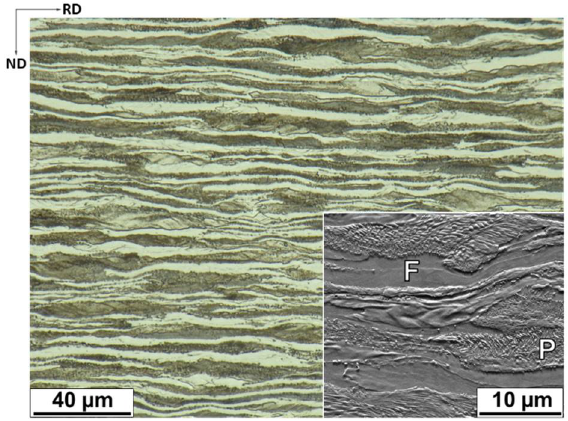
Figure 1. Microstructure of the steel in as-received 70% cold-rolled steel. Cold-rolled samples of dimensions 10 × 5 × 1.2 mm 3 and 90 × 20 × 1.2 mm 3 , with the